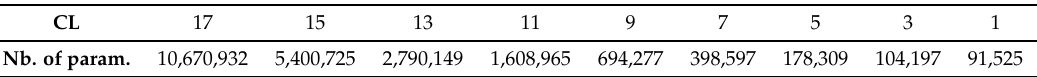
Figure 2. Depth reduction of a deep neural network: in the initial network, each residual layer contains two Convolutional Layers (CLs) ( left ); the last residual layer is removed ( middle ) to obtain a shallower network ( right ). Table 1. Number of CLs and the number of learnable parameters in the proposed